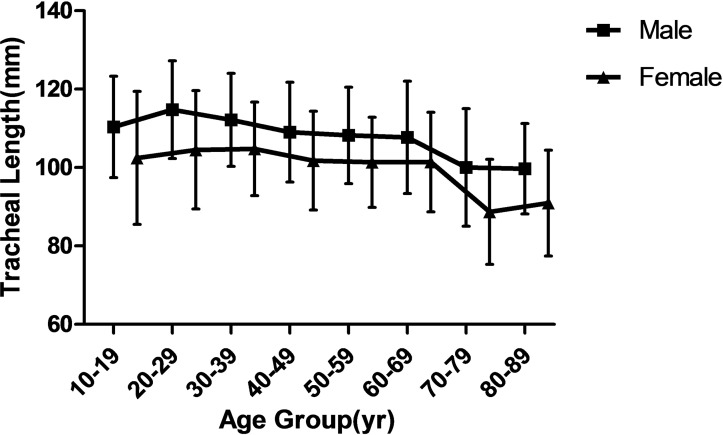
Lengths of trachea from subjects with age 18 to 90.Values for each 10 year period were averaged.